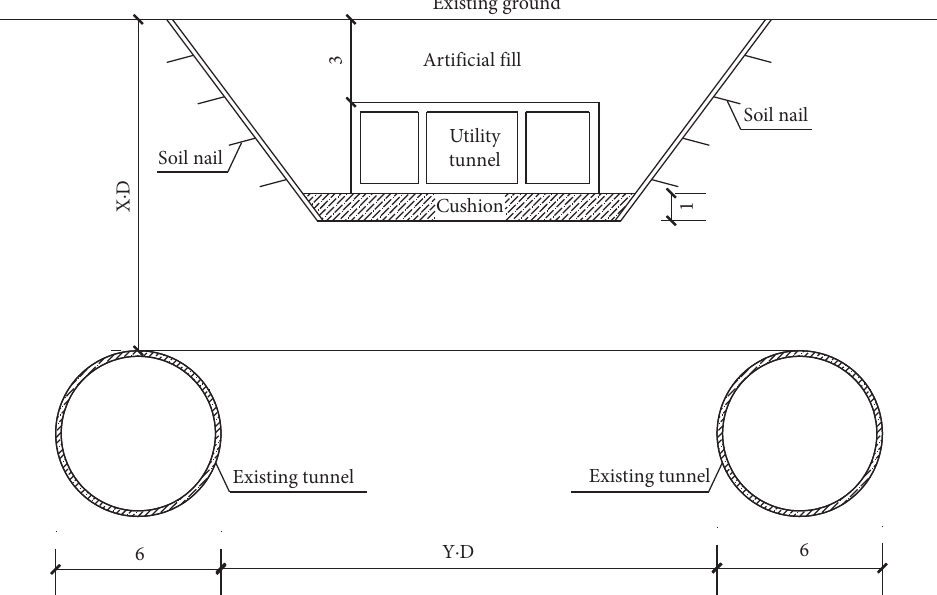
Figure 1: Sketch of relative position of utility tunnel and metro tunnel (unit: m). D represents the diameter of the